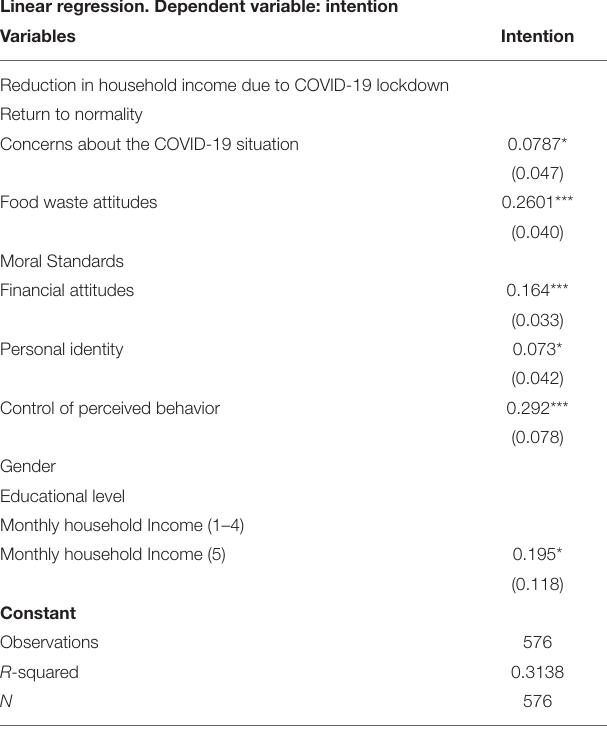
TABLE A1 | Linear regression for the variable intention to not waste food (robustness check). Linear regression. Dependent variable: intention